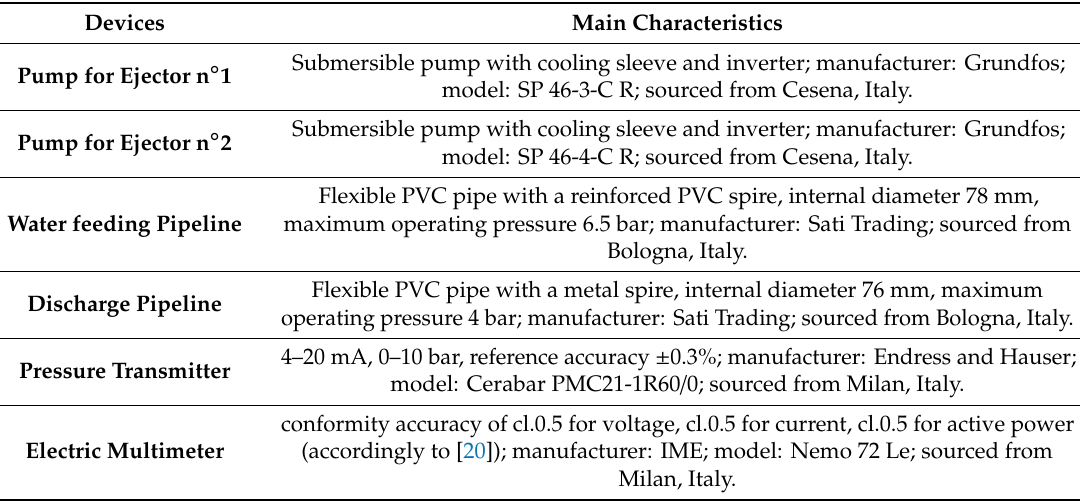
Figure 6. Position of ejectors, pumps and electric panel. Table 2. Characteristics of the main components of the Cattolica pilot plant.